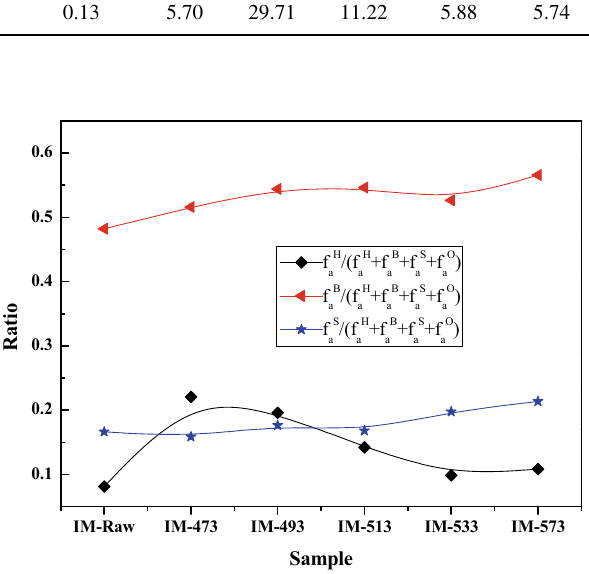
Fig. 5 Variation of the ratio of protonated aromatic carbon, bridging ring junction aromatic carbon, and aliphatic substituted aromatic carbon to the aromatic